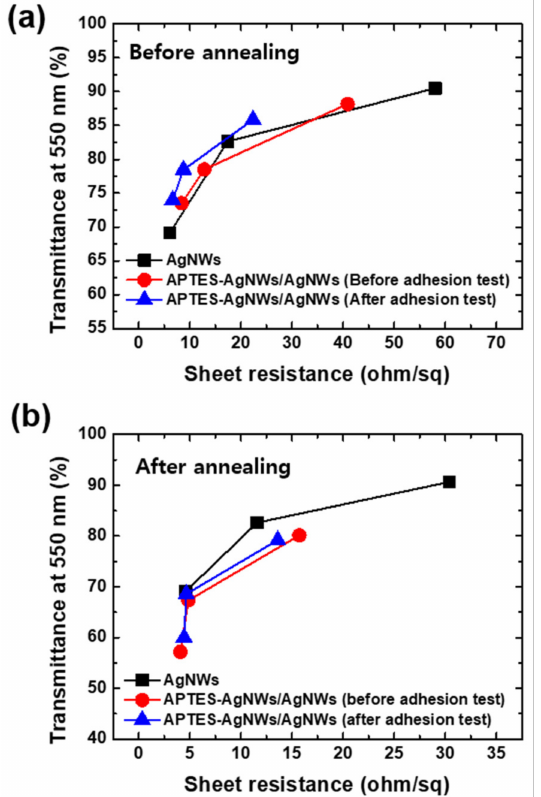
Figure 7. Transmittance at λ = 550 nm of the AgNWs networked films ( a ) before and ( b ) after annealing as a function of the sheet resistance. The solid lines are the fit to Equation (1). The bare AgNWs films were deposited on the glass substrate using 20 µ L of the 0.5 wt.% AgNWs suspension at NC = 1–3. The APTES-AgNWs were coated on the bare AgNWs networked films using 8 µ L of the 0.32 wt.% APTES-AgNW suspension at NC = 1. The AgNWs films were annealed at 180 ◦ C for 5 min on a